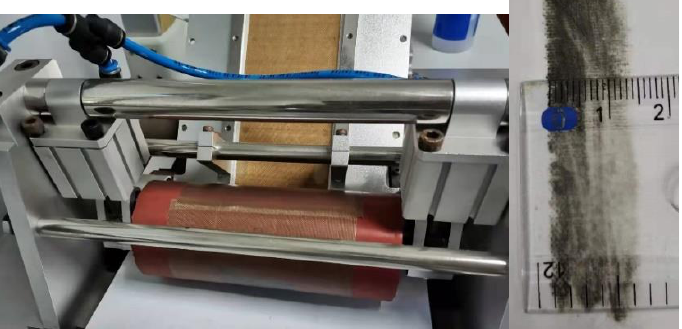
Figure 6. Measurement experiment of contact length of the flexible compactor.